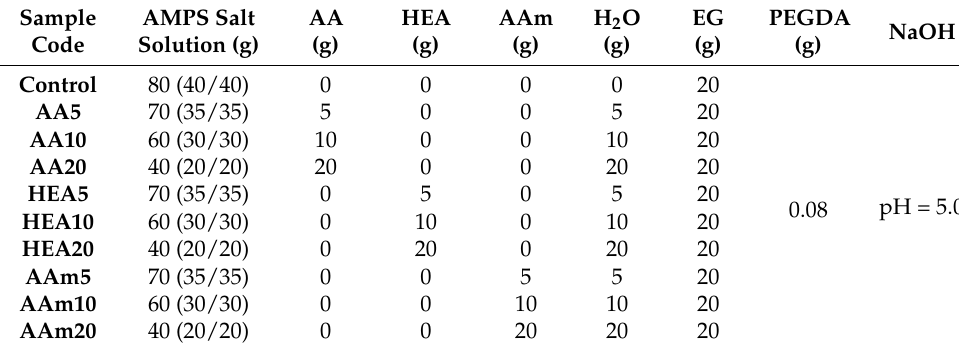
Table 1. Compositions of AMPS hydrogels modified with comonomers.